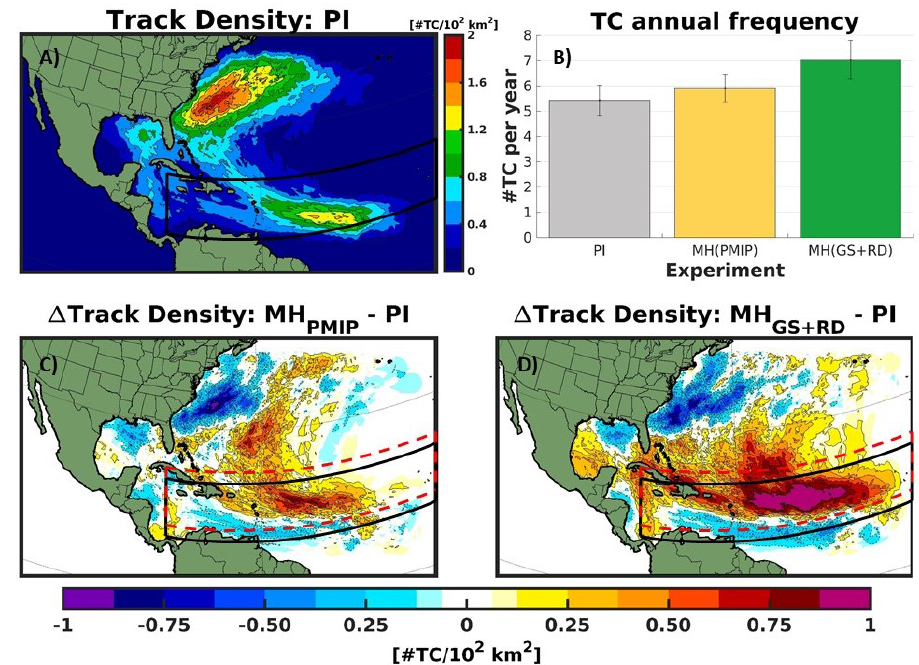
Figure 2. June to November (JJASON) climatology of (a) track density for the pre-industrial (PI) experiment; (b) TC frequency in the Atlantic Ocean for each experiment. Error bars (whiskers) indicate the standard error of the mean; changes in track density for the MH PMIP (c) and the MH GS + RD (d) experiments relative to the PI. The black box shows the present-day MDR; the dotted red box shows the approximate shift of the MDR in the MH experiments. Only values that are significantly different at the 5% level using a local (grid-point) t test are shaded. The contour lines follow the color-bar scale (dashed, negative anomalies; solid, positive anomalies); the 0 line is omitted for clarity.